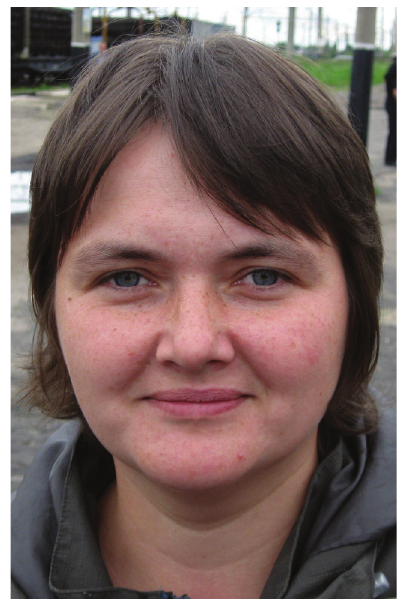
Figure 8. Dr. Martha K. Leontovich. The photograph was taken by the